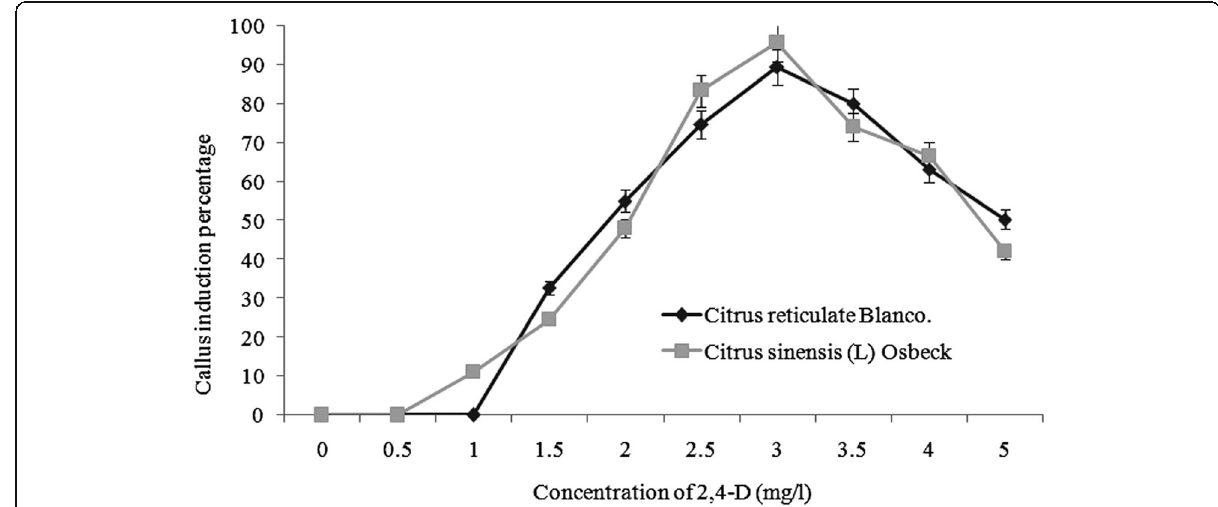
Fig. 2 Role of 2,4-D on callus induction in Citrus reticulata Blanco and Citrus sinensis (L.) Osbeck